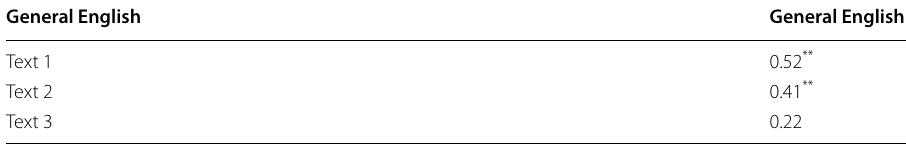
Table 5 Correlations between General English, text 1, text 2, and text 3: Pearson product‑moment correlation coefficients ( n =